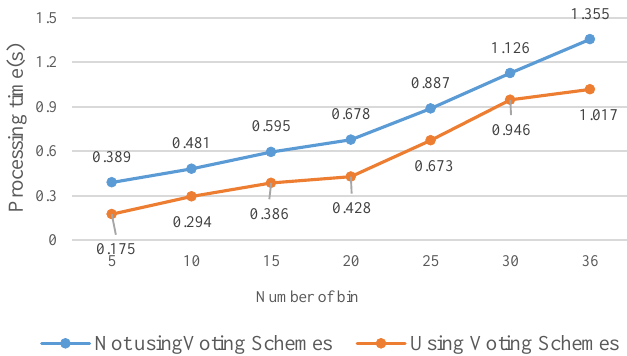
Figure 19. Calculation time required for the FBRLF when the voting mechanism and lookup table method are applied.